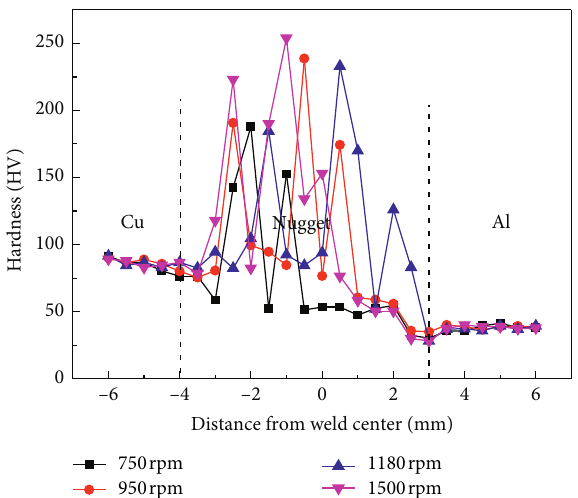
Figure 9: The microhardness distribution of joints at different rotation speeds.